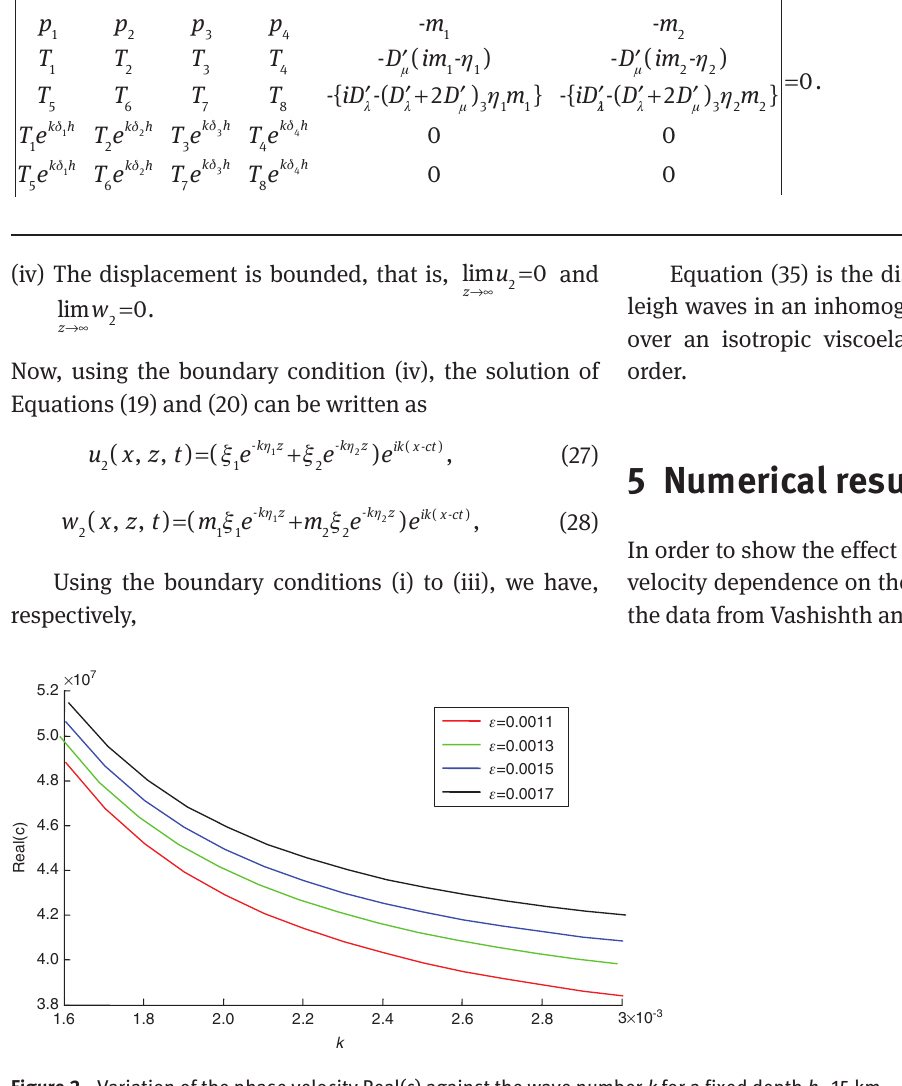
Figure 2 Variation of the phase velocity Real(c) against the wave number k for a fixed depth h = 15